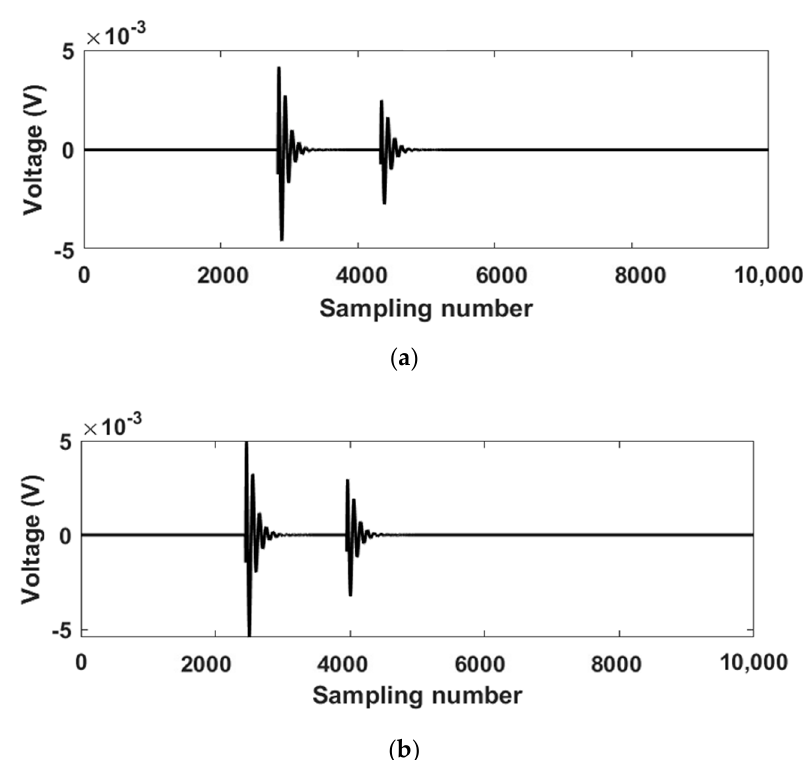
Figure 3. ( a ) Simulated PD signals measured at PD Sensor A. ( b ) Simulated PD signals measured at PD Sensor B.